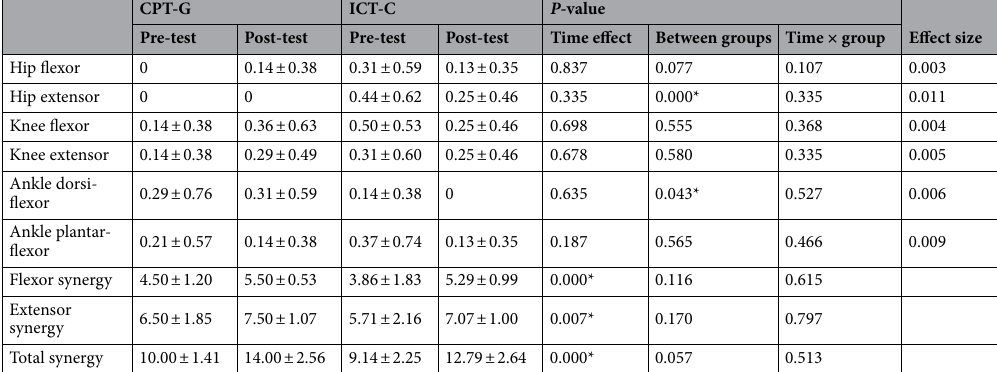
Table 4. Modified Ashworth scale and Fugle-Meyer assessment lower extremity. MAS modified Ashworth scale, CPT-G conventional physical therapy and gait training, ICT-C ankle–knee–hip interlimb coordinated humanoid robot combined with conventional physical therapy, FMA-LE Fugl-Meyer assessment lower extremity; *Denotes significance level at P < 0.05.